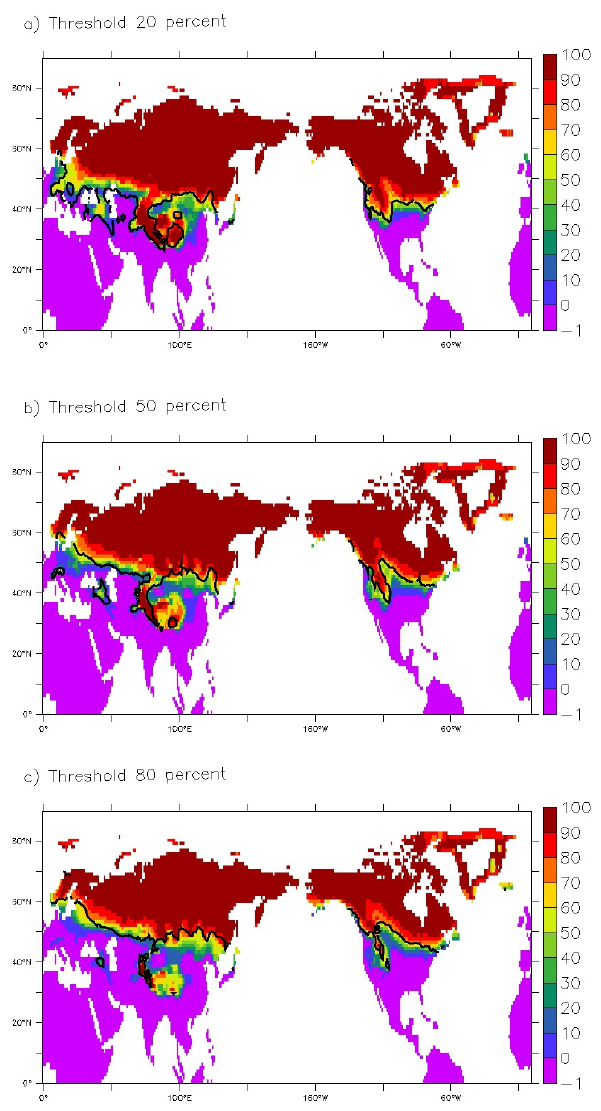
Figure 3 : Percentage of models that simulate a frequency of snow cover in March in excess of a given threshold (shading, in %), and southern limit of the area where the probability of observing snow cover in march is higher than this threshold (black contour), both for the 1979-2005 period. a) threshold 20%; b) threshold 50%; c) threshold 80%.